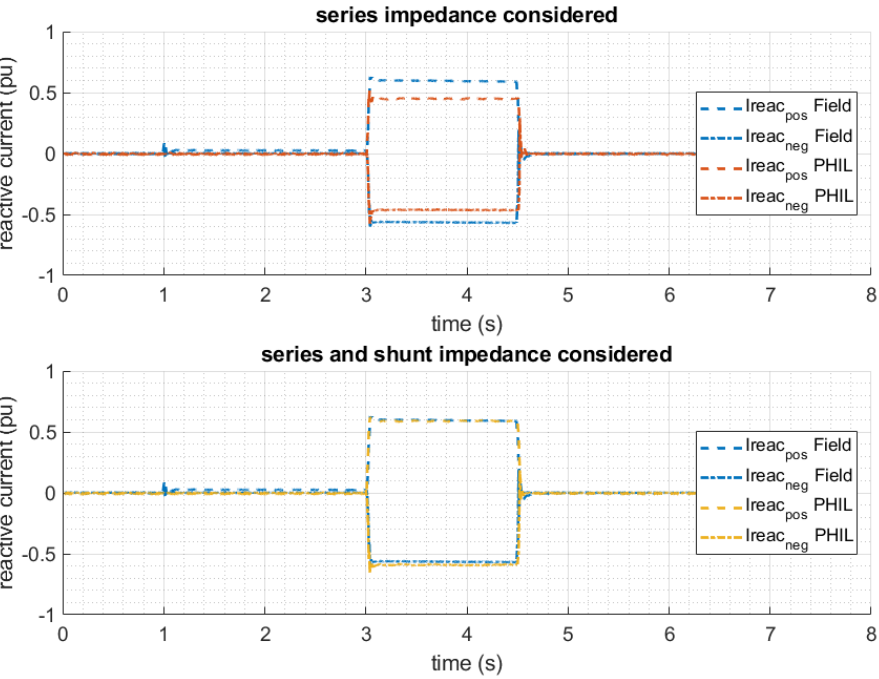
Figure 10. Comparison of the positive and negative sequence reactive current between a field and a grid emulator measurement using the PHiL setup.